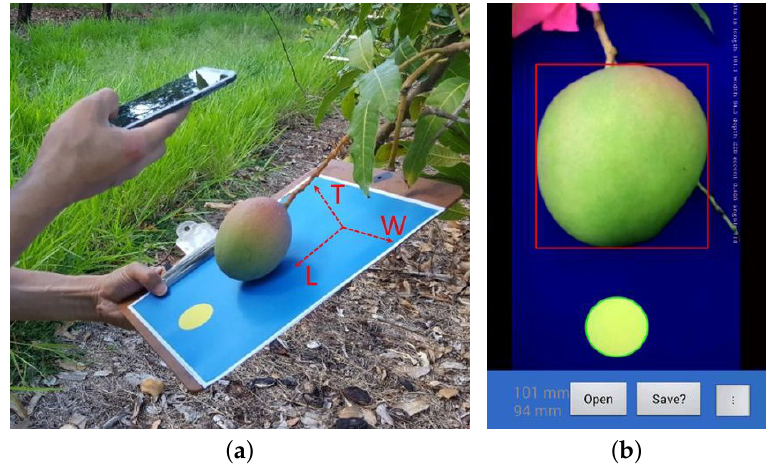
Figure 30. FruitSize: ( a ) Example of fruit photo capture; ( b ) Result of fruit size